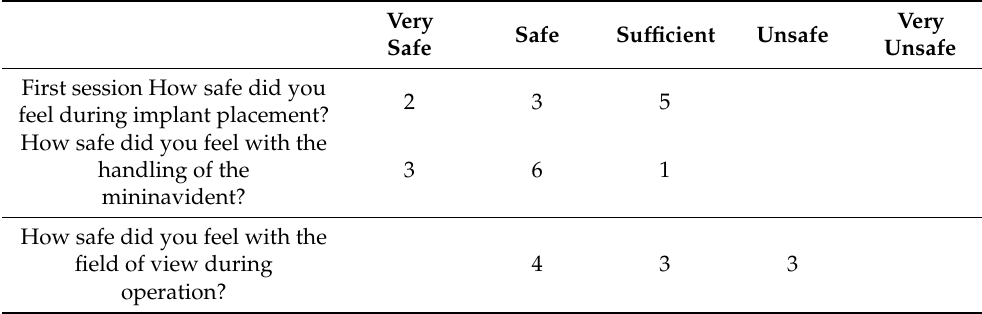
Table 3. Responses of the ten students regarding subjective reliability in using a dynamic computer- assisted surgical system in dental implant placement (second session).